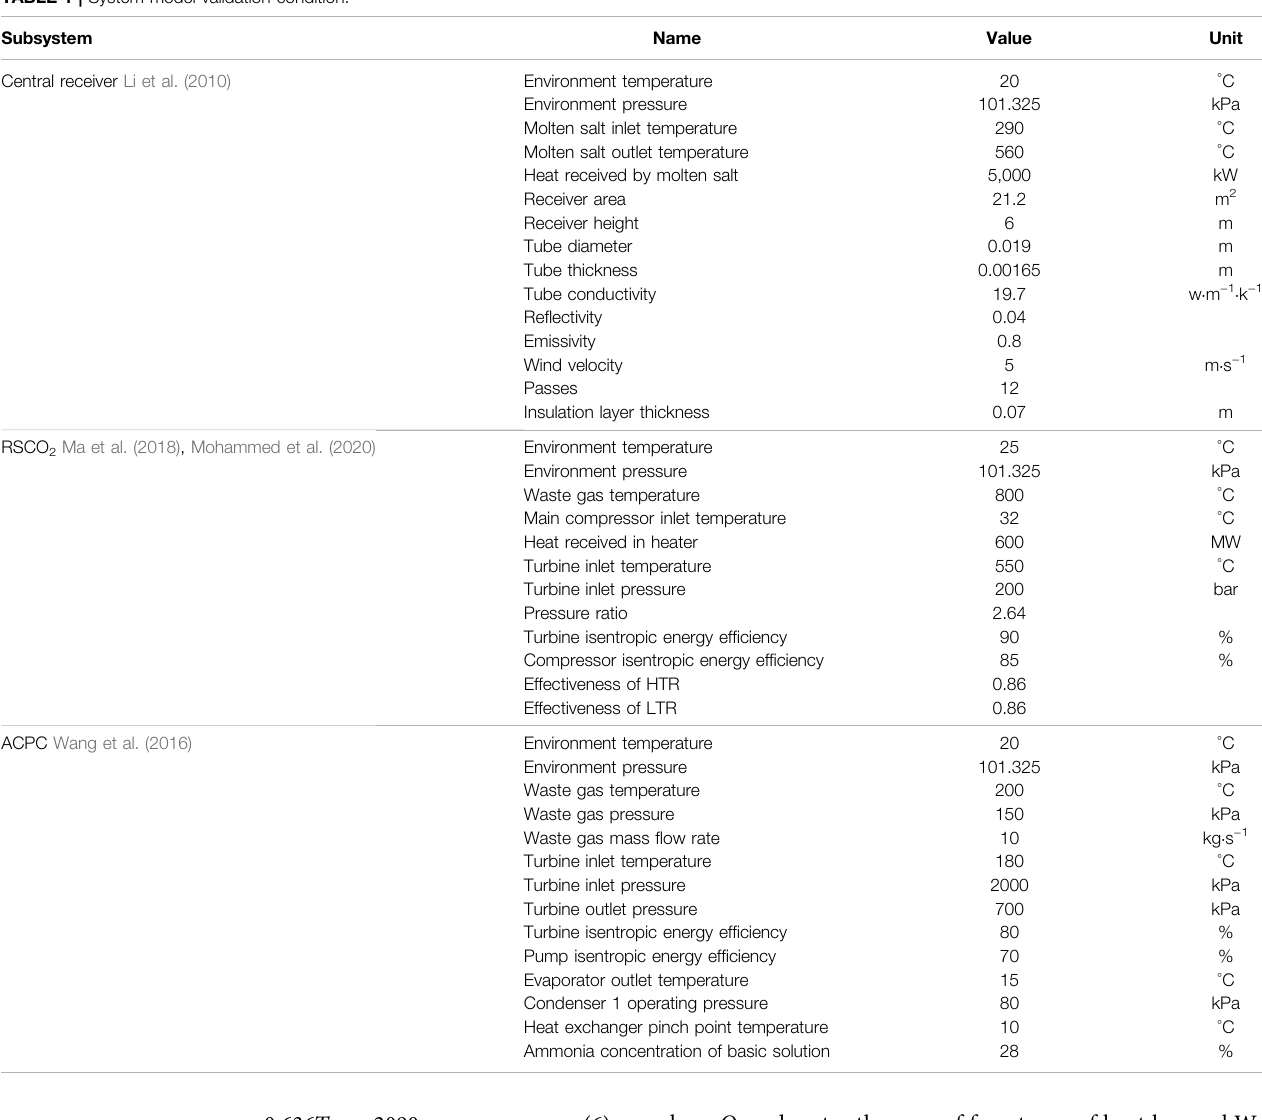
TABLE 1 | System model validation